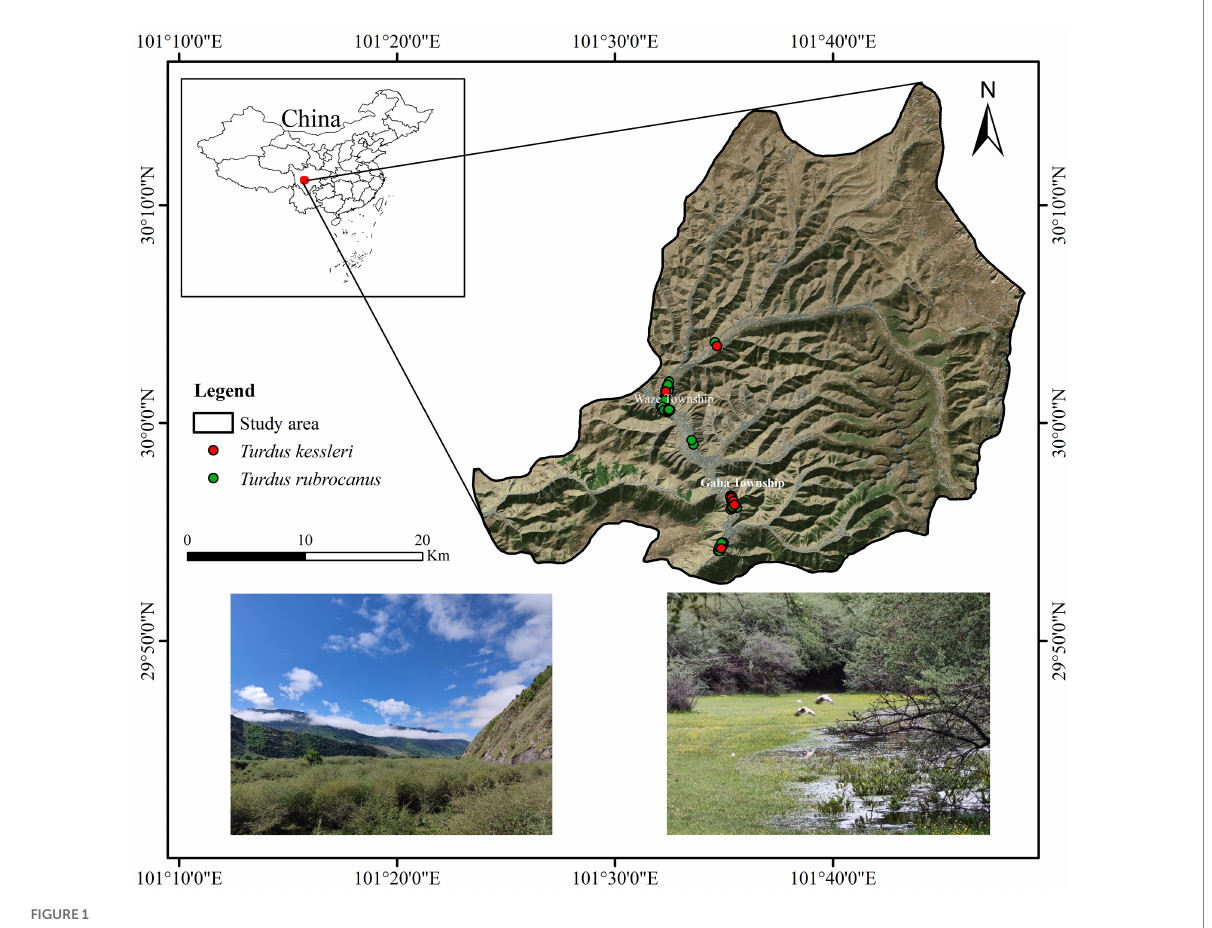
FIGURE 1 Study area and nest